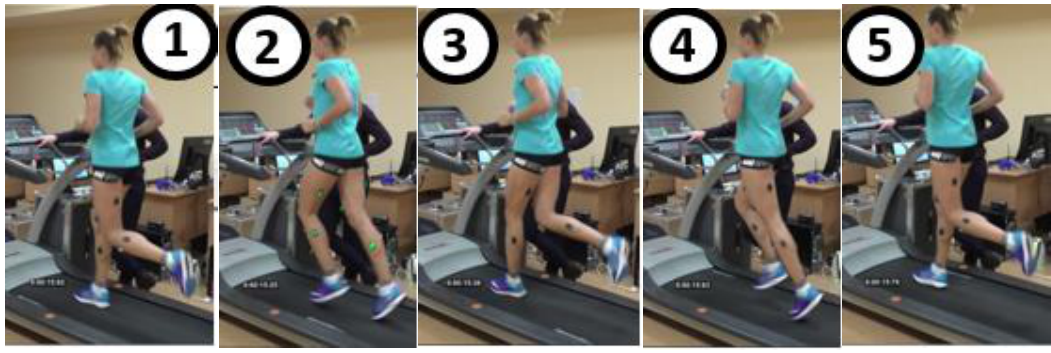
Figure 2 . Test cyclic asymmetric movement (running on a treadbana).